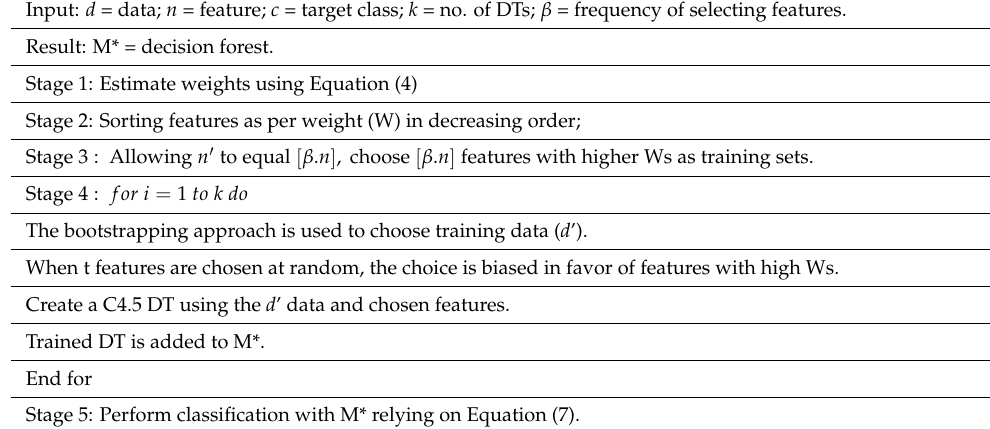
Algorithm 1: ASV-RF’s